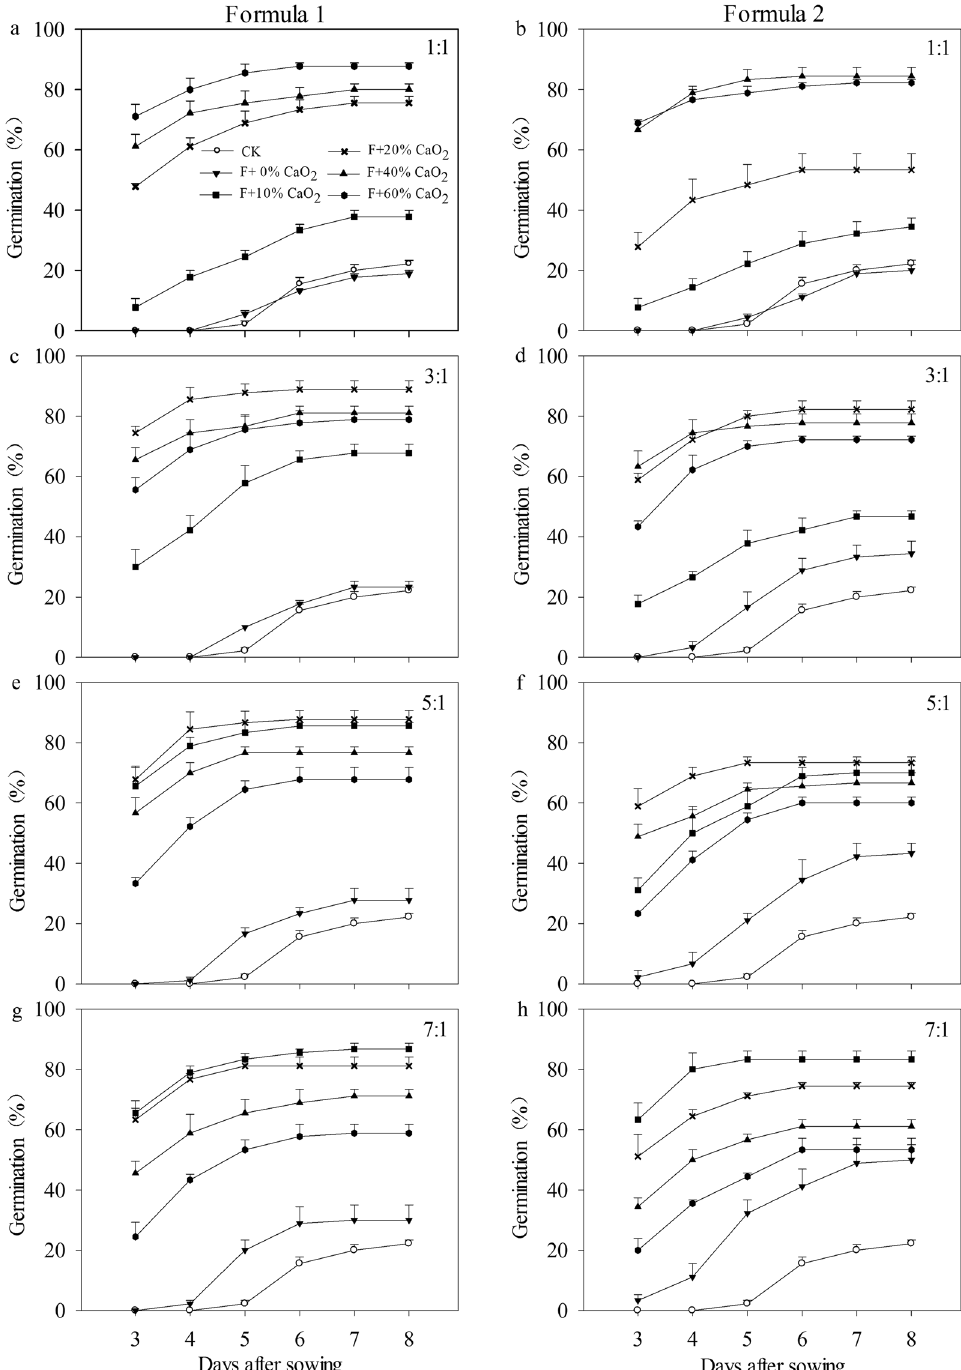
Figure 2. Germination dynamics of pelleted seeds in two formulae with various pelleting times and CaO 2 contents under waterlogging conditions (1.5 cm water layer) in Experiment 2. Seeds were pelleted in Formula 1 ( a (pelleting time of 1), c (pelleting time of 3), e (pelleting time of 5), g (pelleting time of 7)) and Formula 2 ( b (pelleting time of 1), d (pelleting time of 3), f (pelleting time of 5), h (pelleting time of 7)). CK: naked seeds. F + 0% CaO 2 : Seeds were pelleted by pelleting agents without CaO 2 . F + 10% CaO 2 : Seeds were pelleted by pelleting agents with 10% of CaO 2 . F + 20% CaO 2 : Seeds were pelleted by pelleting agents with 20% of CaO 2 . F + 40% CaO 2 : Seeds were pelleted by pelleting agents with 40% of CaO 2 . F + 60% CaO 2 : Seeds were pelleted by pelleting agents with 60% of CaO 2 . Seed germination data were recorded from 3 DAS until constant at 8 DAS. Error bars indicate standard error (n =